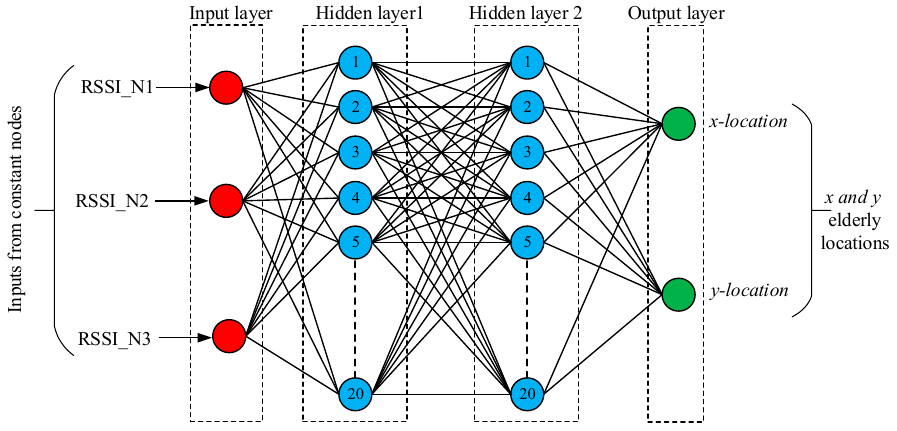
Figure 9. Performance of MSE of validation data for the ( a ) LOS and ( b ) NLOS environments using one hidden layer.